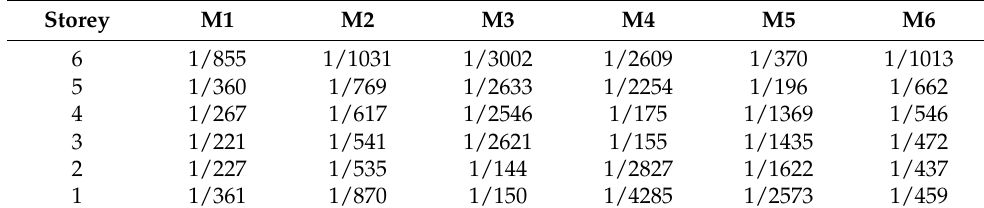
Table 9. The interstorey drift ratio of models at the performance point.